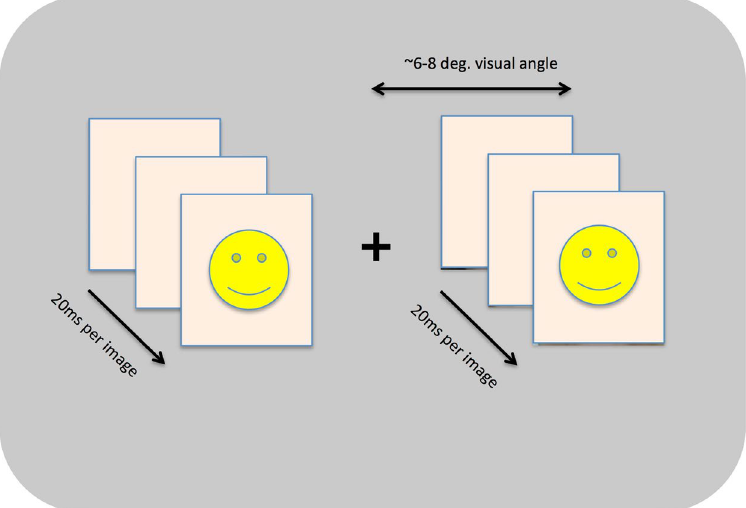
Figure 1. A schematic view of our basic FFDE paradigm. We presented images in rapid succession on either side of a central fixation point, which observers were asked to maintain fixation on during each trial. On each trial, participants were asked to rate the strength of the FFDE on a 1–7 scale after the image sequence concluded. The set of images to be included in the FFDE sequence was randomly sampled on each trial and their order within the sequence was also shuffled randomly on each trial. Across experiments, we varied a range of stimulus parameters within this basic framework including image orientation, the presence/absence of make-up, the duration of images within the sequences, and the eccentricity and size of those images.